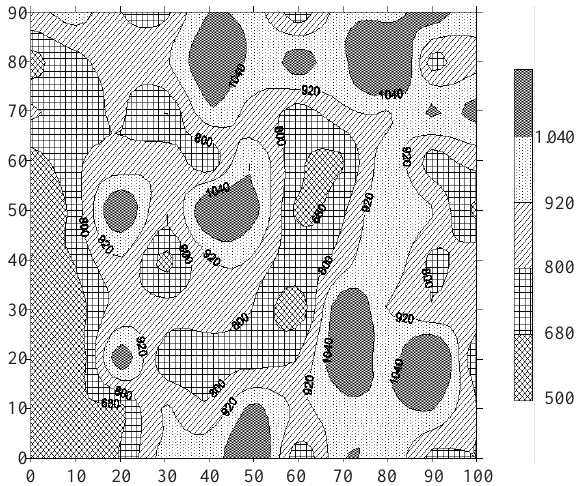
Figura 2. Mapa de produtividade de arroz (A4) em kg ha -1 – Votuporanga, 1994.